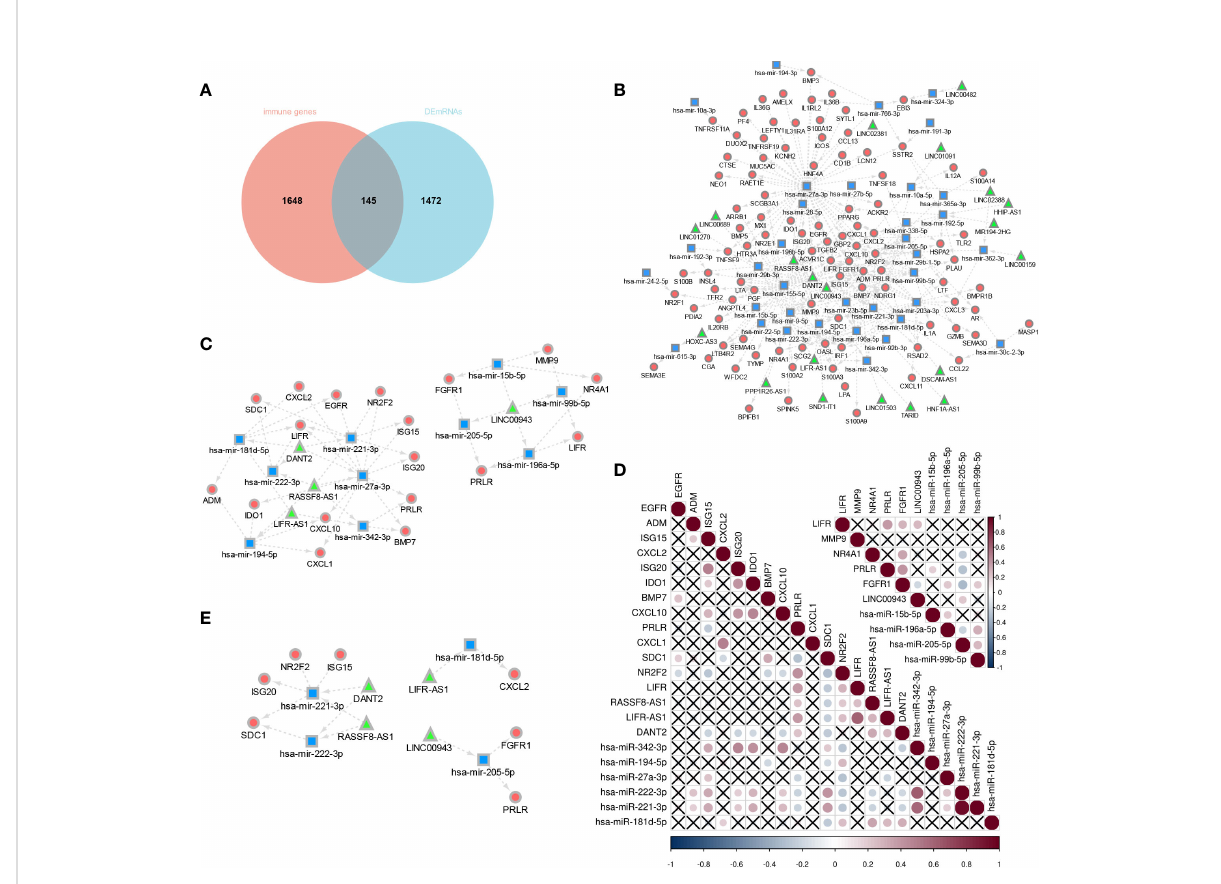
FIGURE 8 Construction of E6 splicing Immune-related ceRNA Networks. (A) Intersection between DEmRNA and immune genes. (B) ceRNA network among IncRNAs, miRNAs, and mRNAs, Circular, mRNAs: square, IncRNAs; triangle, miRNAs. (C) A subnetwork from the ceRNA network (D) Co- expression analysis of DEGS in sub-network. (E) 14 hub genes of E6 splicing Immune-related ceRNA